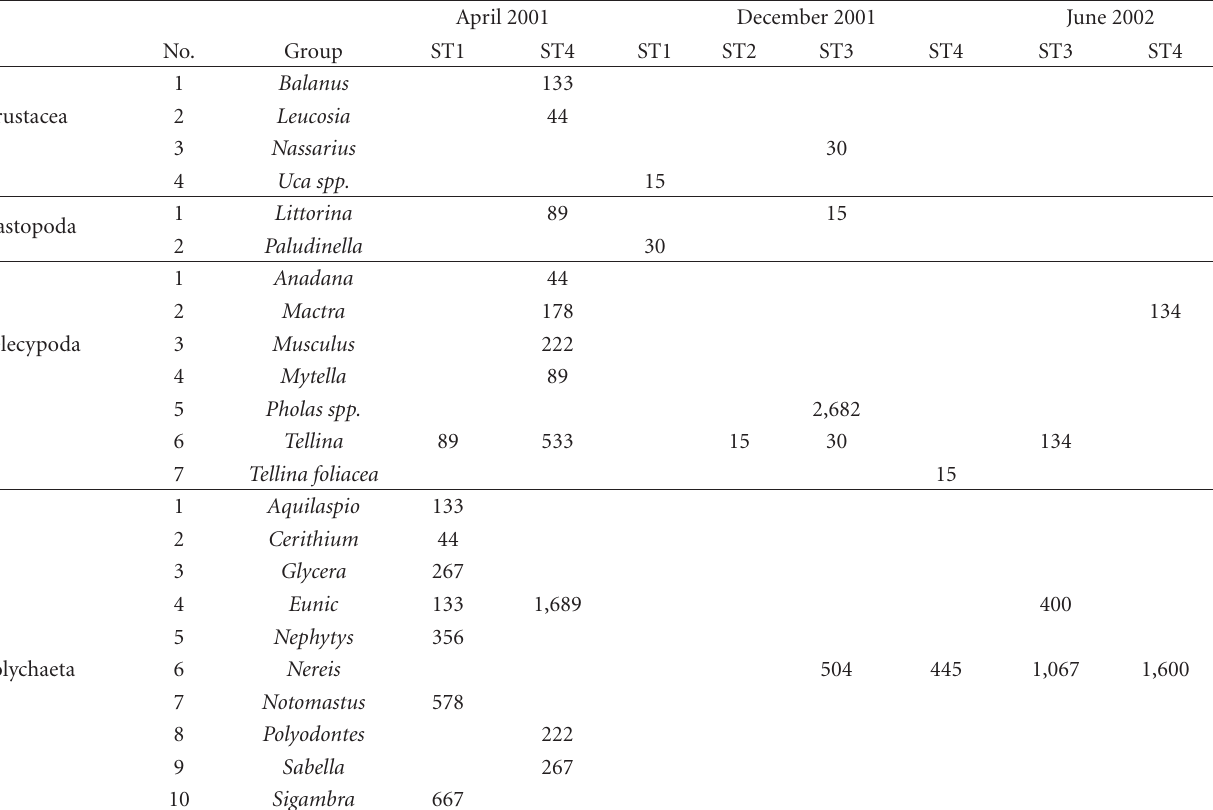
Table 3: Species of benthic fauna and abundance (individuals/m 2 ) within sediment and bottom of the replanted mangrove areas.